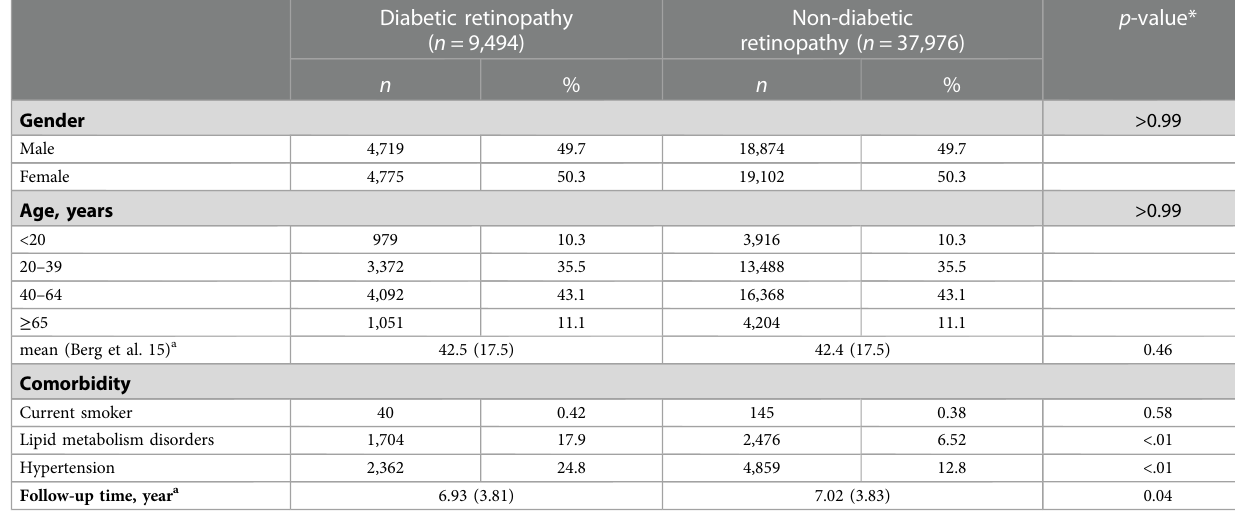
TABLE 1 Baseline characteristics of